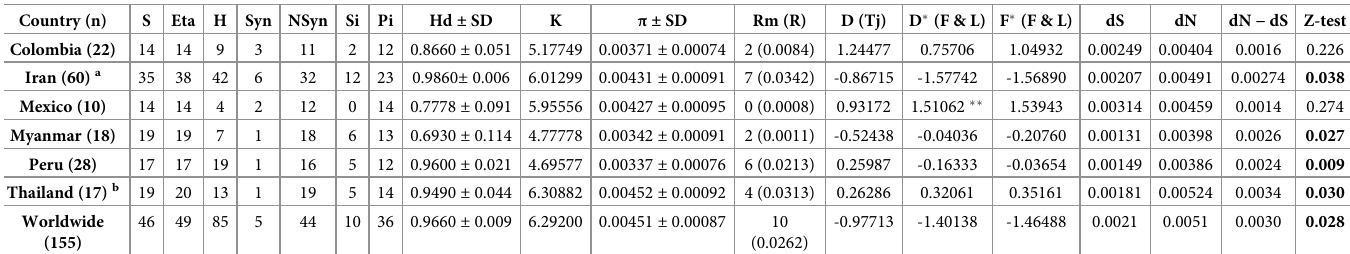
Table 2. DNA polymorphism data and neutrality analysis for global pvrbp2b gene appraised by using DnaSP and MEGA6 programs (nt: 502–1896). Country (n) S Eta H Syn NSyn Si